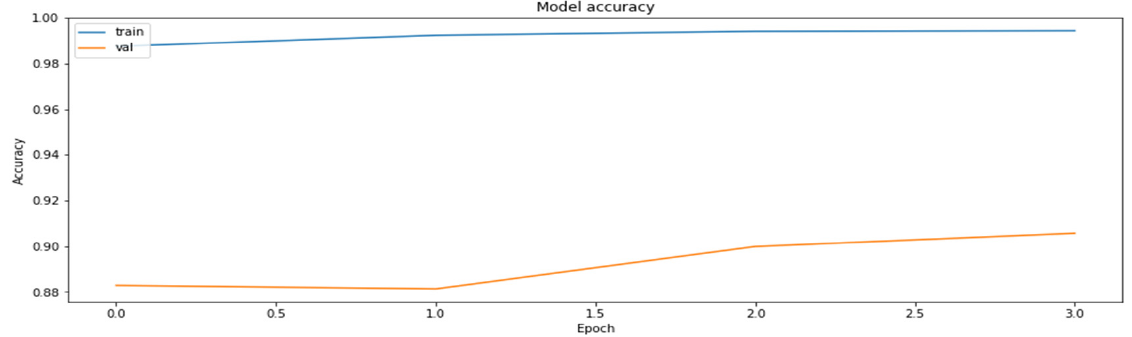
Figure 8. Training and the validation datasets obtained during the application of the pruning part of the PCQAT.